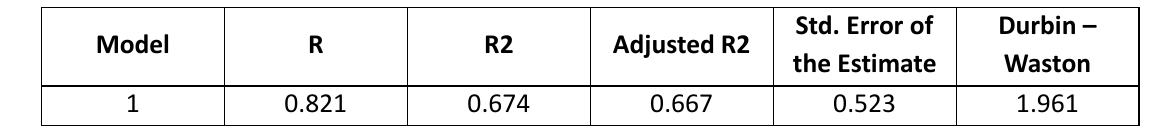
Table 4. Model summary